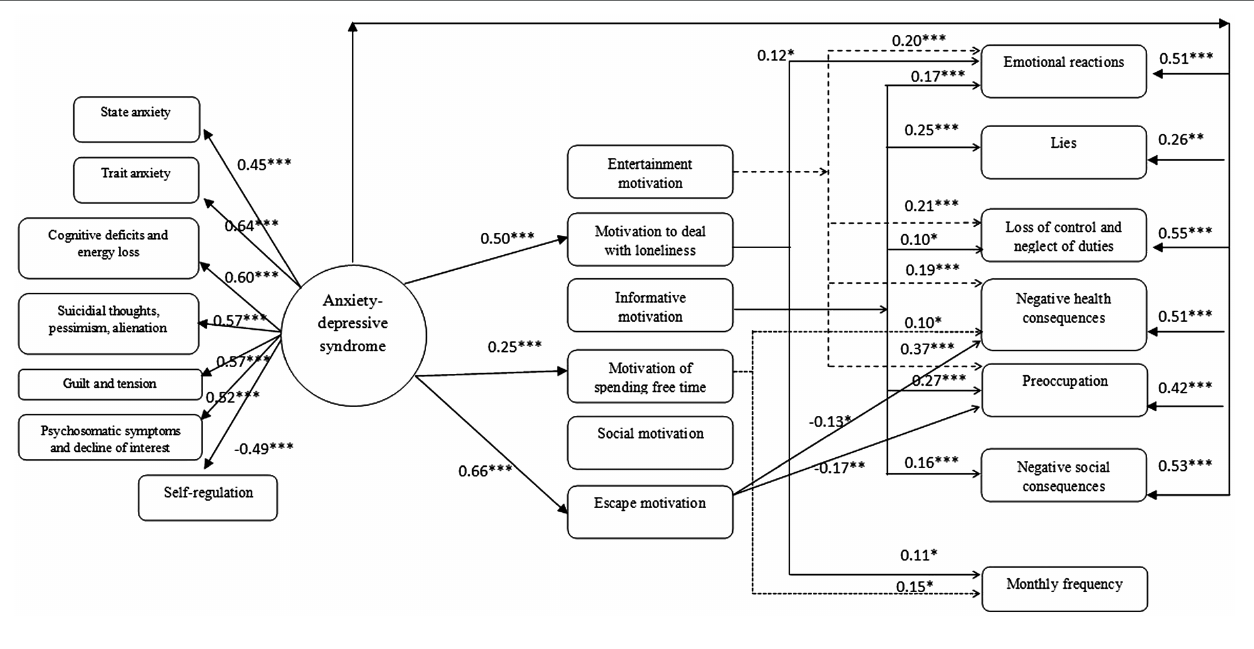
FIGURE 2 | Path analysis model. * p ≤ 0.05; ** p ≤ 0.01; *** p ≤